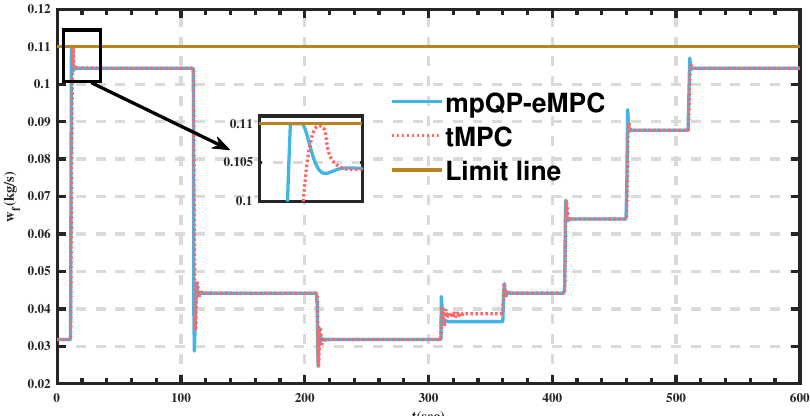
Figure 13. The input signal of collective pitch.